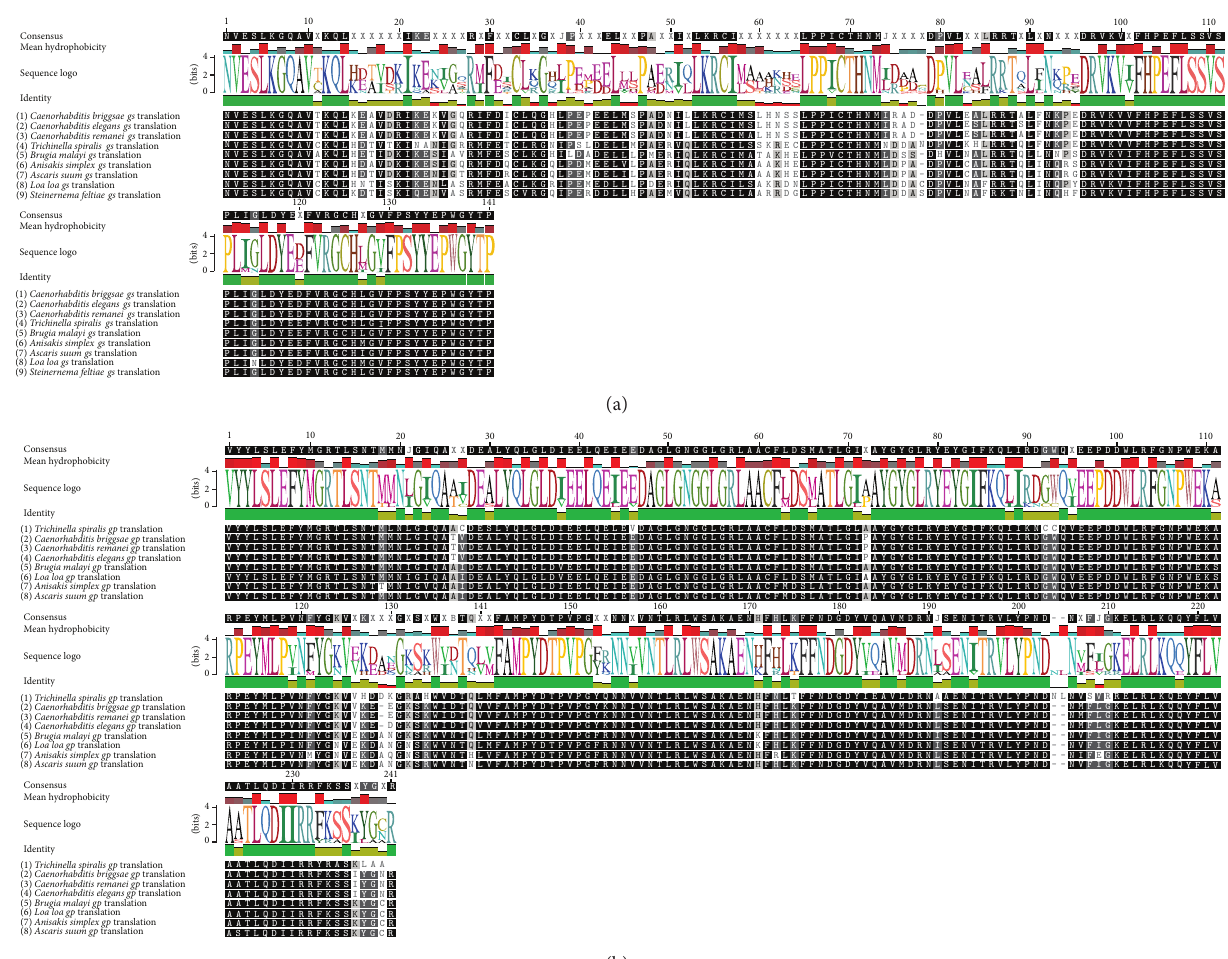
Figure 2: Multiple alignment of predicted partial deduced amino acid sequences of glycogen synthase (a) and glycogen phosphorylase (b) fromnematodes:third-stage(L3)larvaeof Anisakissimplex , Loaloa , Caenorhabditiselegans , C.remanei , C.briggsae , Trichinellaspiralis , Brugia malayi , Ascaris suum , and Steinernema feltiae . The legend is the same as in Figure